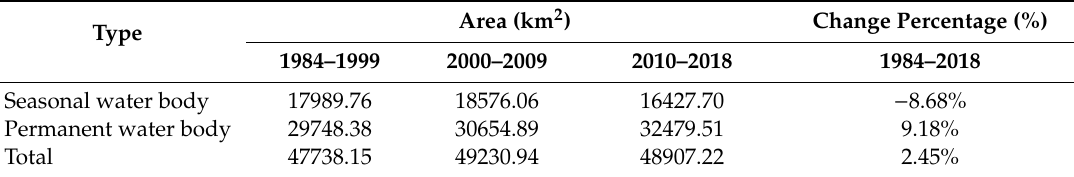
Table 3. The area of surface water bodies during di ff erent periods in the YRB. Table 3 The area of surface water bodies during different periods in the YRB.